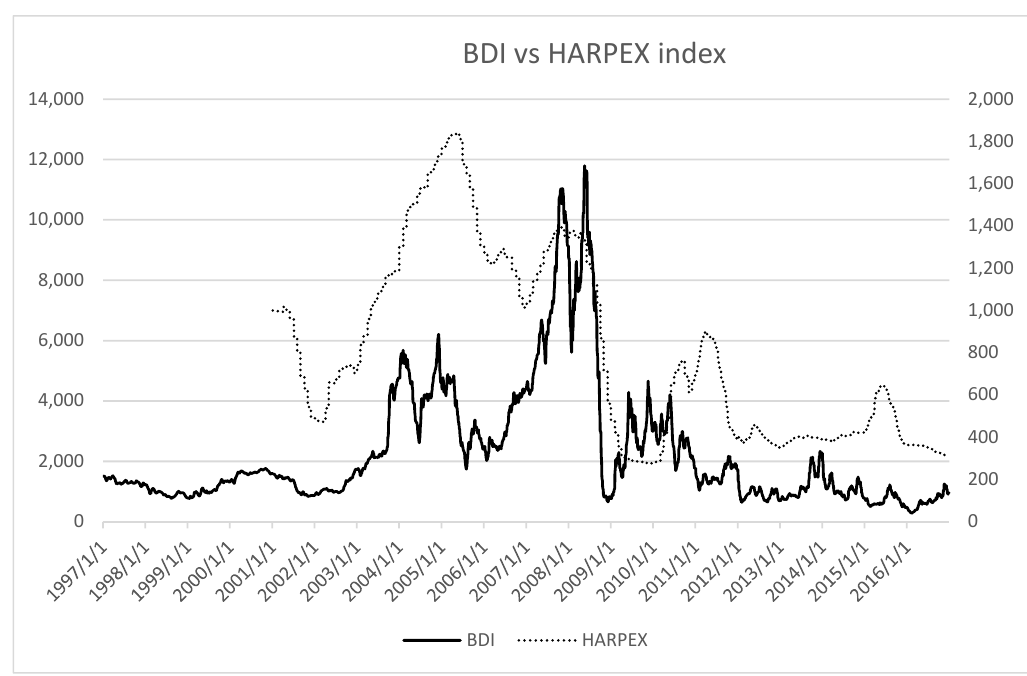
Figure 3. Baltic Dry Index versus Harpex Container Freight Index. Note: BDI, the Baltic Exchange Dry Index, is on the left-hand axis, and Harpex, the container freight index, is on the right-hand axis. Table 1. Descriptive